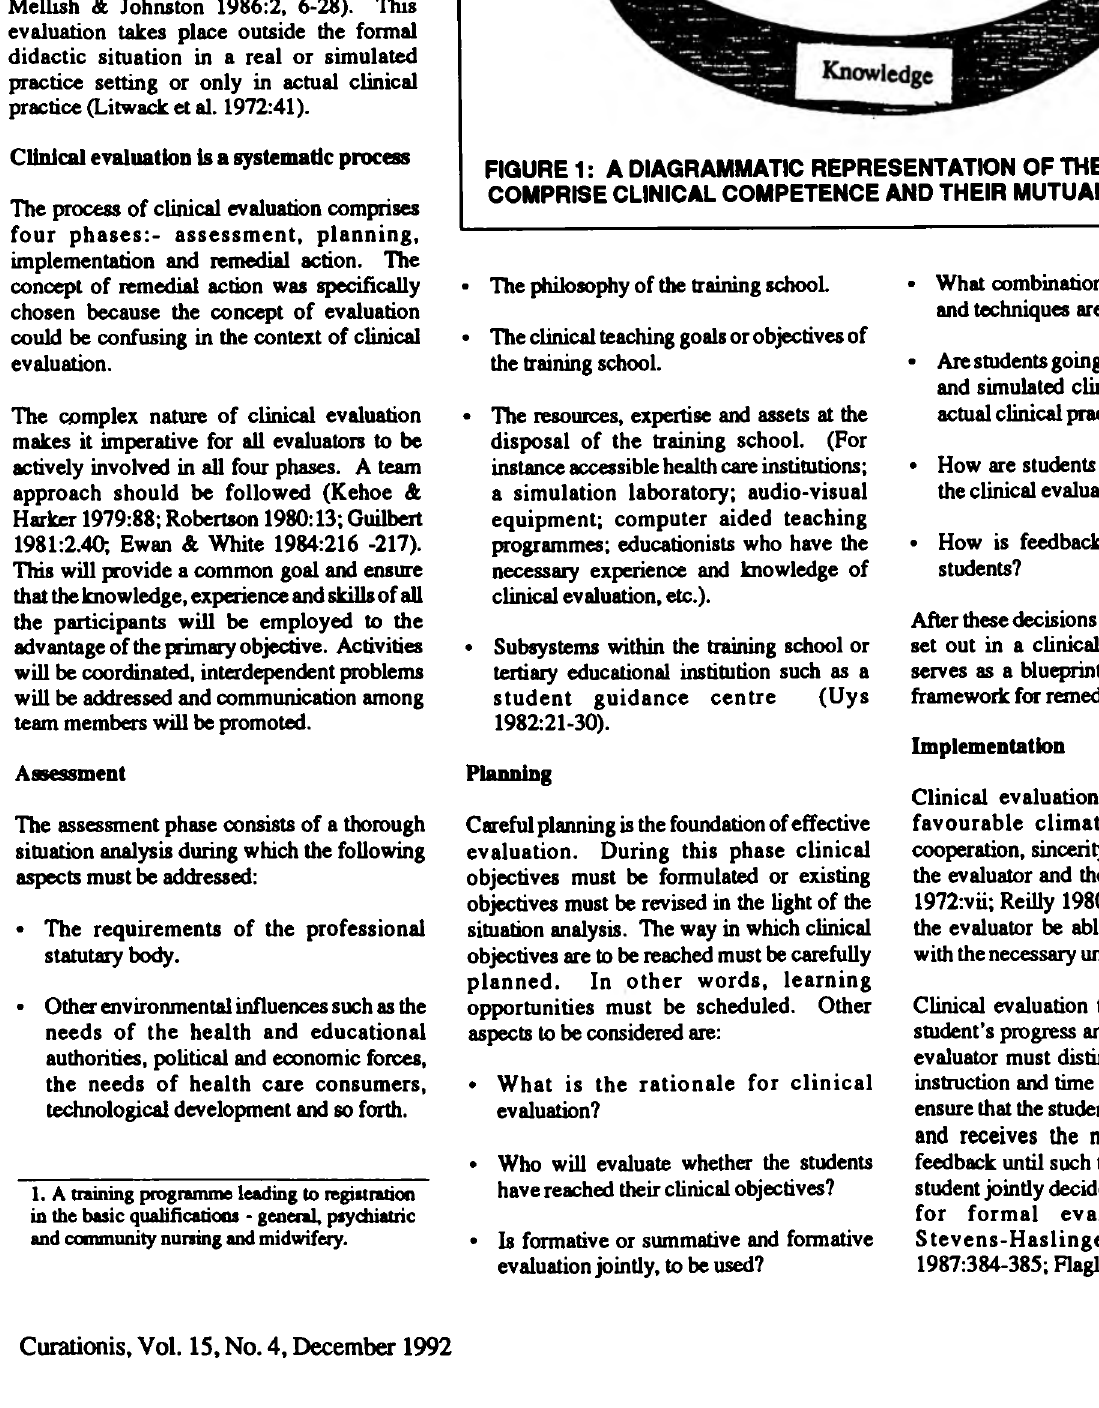
FIGURE 1: A DIAGRAMMATIC REPRESENTATION OF THE FACETS WHICH COMPRISE CLINICAL COMPETENCE AND THEIR MUTUAL